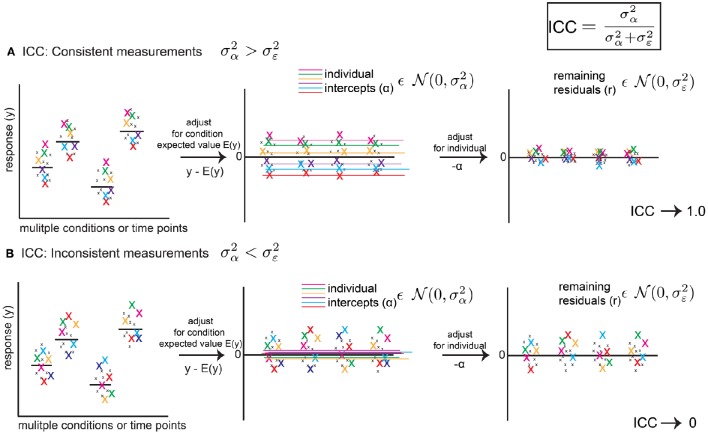
The Intra-Class Correlation (ICC) defined from a linear mixed model (LMM) reflects the level of behavioral consistency of individual animals across multiple measurements. The ICC (upper right) is defined as σα2/(σα2+σε2), using mixed model random variance terms, and represents consistency of behavior across multiple measurements, where σα2 is the random effect variance term and σε2 is the error variance term from the LMM (fitting a random intercept only, as a function of animal identity). (A) Hypothetical scenario showing how the ICC reflects a consistent pattern. Left Panel: a response variable (e.g., rate of ultrasonic calls per minute) is measured for the same six animals(color coded x's) across conditions and time points. Middle Panel: After adjusting for expected values E(y) (e.g., group means or regression predictions for variables such as age or strain), random intercepts reflect an average expectation for a particular animal's position in the distribution of residuals. If measurements are consistent, the variance of these intercepts (σα2) reflects most of the remaining variance in the data. Right Panel: After adjusting for intercepts α, residuals are squeezed toward zero. Thus, σα2≫σε2 and the ICC approaches 1.0. (B) Hypothetical scenario showing inconsistent measurements. After adjusting for time point or condition (Left Panel), residuals (Middle Panel) vary inconsistently from measurement to measurement for a given animal, and average values across measurements (random intercepts) are close to zero, and σα2 is small and reflects little of the remaining variance in the data. After adjusting for random intercepts, the residuals are mostly unchanged (Right Panel). Thus, σε2≫σα2 and the ICC approaches 0. Thus, the ICC is a metric which summarizes consistency of patterns of behavior across measurements. The ICC is a point estimate, but using a bootstrap procedure we are able to assign confidence intervals to the ICC.